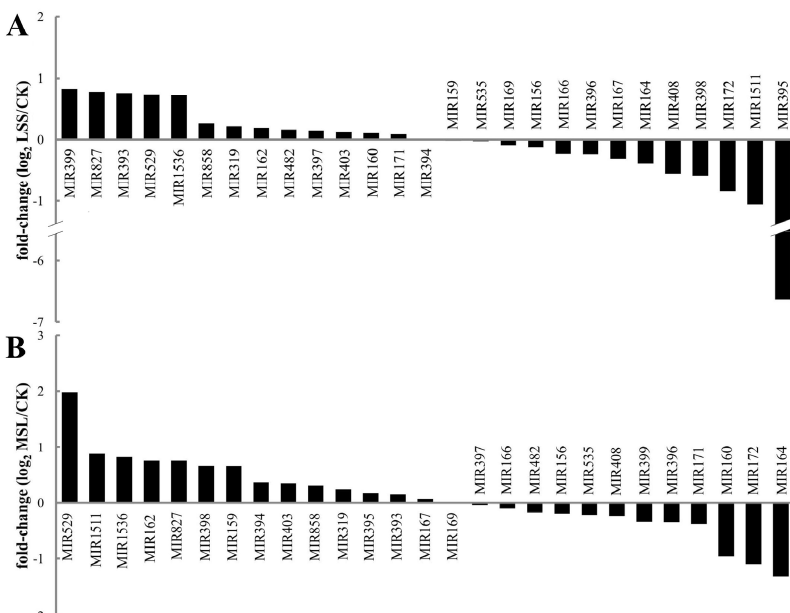
Figure 3. Expression profiles of miRNA families generated via deep sequencing. ( A ) Expression profiles of miRNA families between LSS (light salt stress for a short time) and CK (without salt stress) libraries; ( B ) Expression profiles of miRNA families between MSL (medium ‐ heavy salt stress for a long time) and CK libraries.